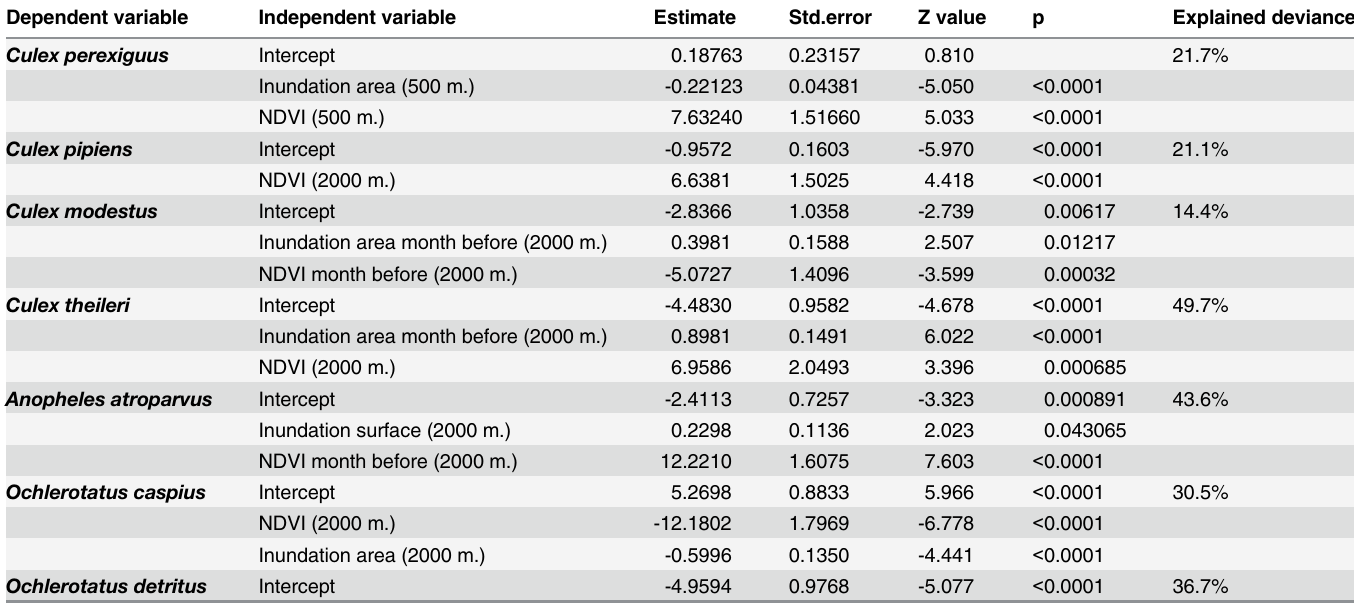
Table 4. Results of the Generalized Linear Model (binomial) of monthly mosquito presence for seven mosquito species vs Inundation surface and NDVI estimated at five buffers of different size.